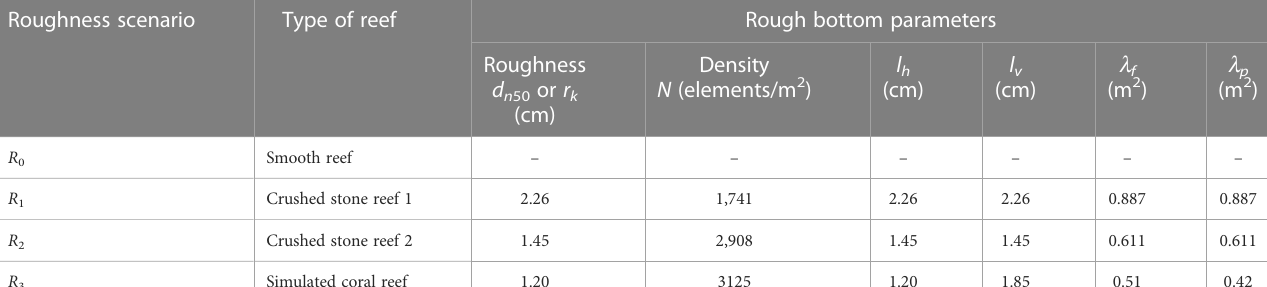
TABLE 1 The tested bottom roughness of the reef. Roughness scenario